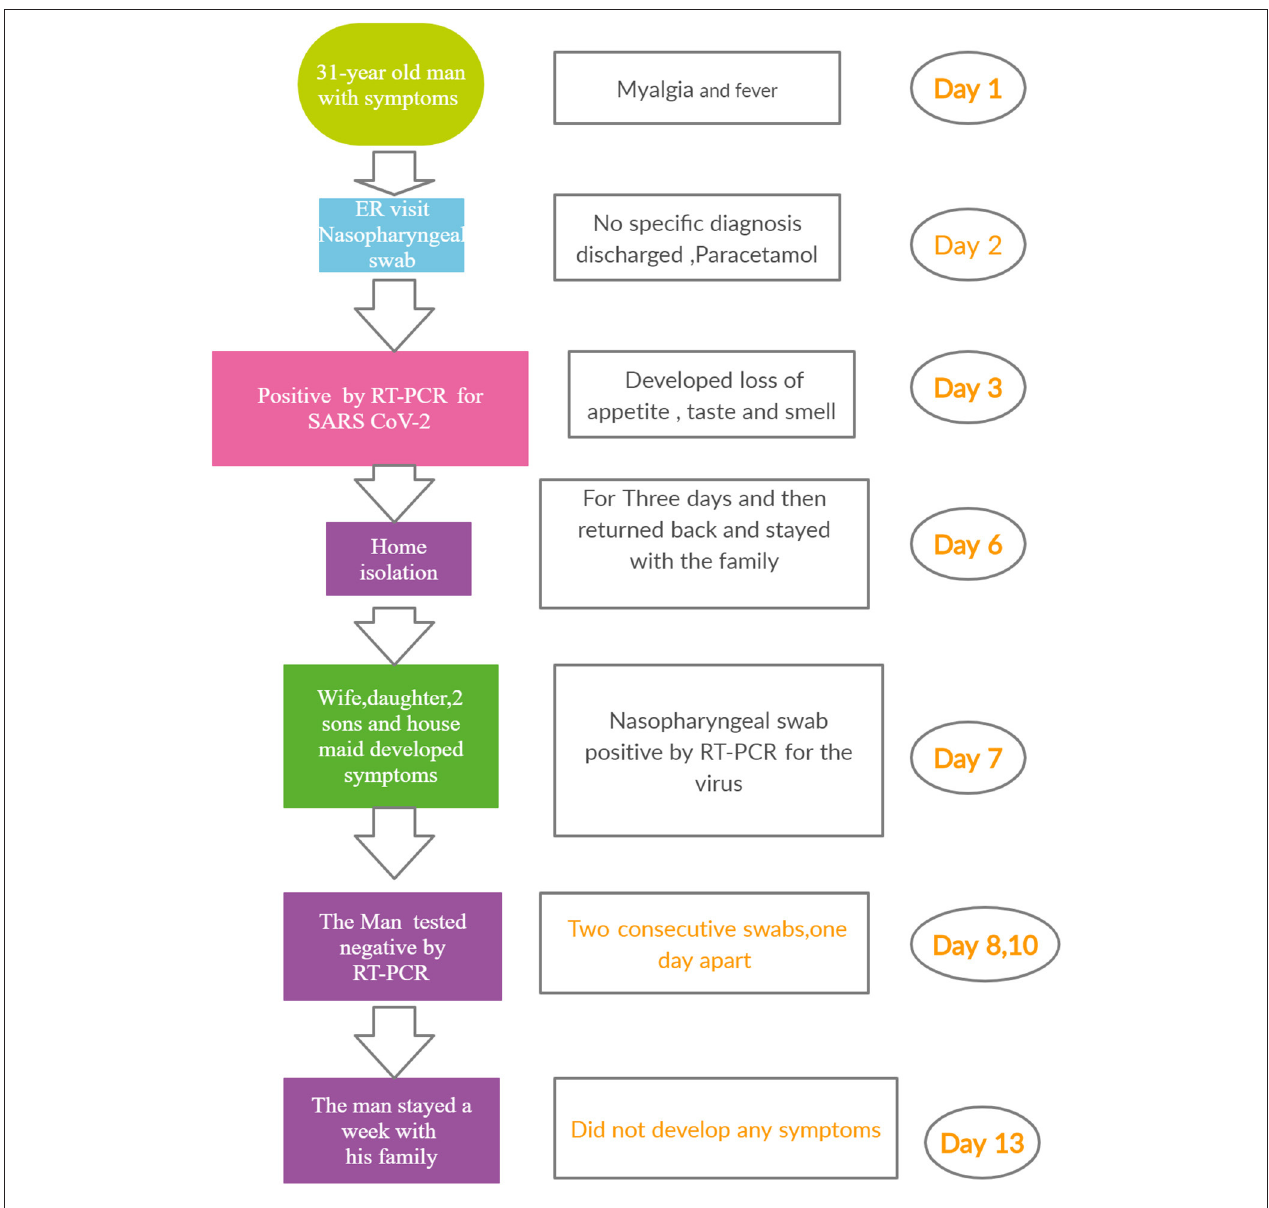
FIGURE 1 | Timeline of case